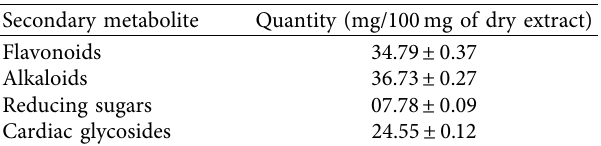
Table 2: Quantitative analysis of the secondary metabolites in CVE (mg/100 mg of the dry extract